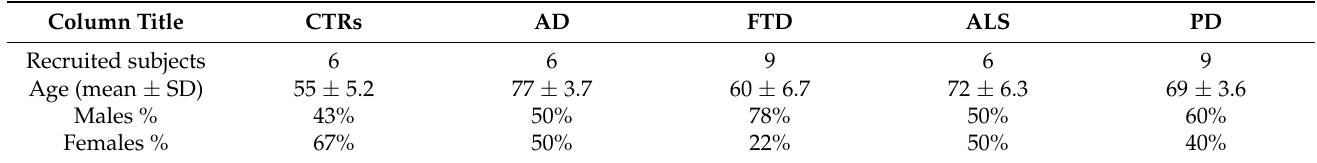
Table 4. Baseline characteristics of recruited subjects for this study. Age is reported as mean ± SD. The percentage of male and female subjects is also indicated.